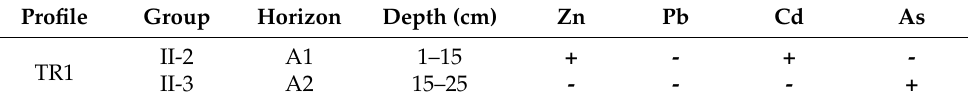
Table 7. Exceeded content of trace elements in soils (group II) according to the Polish regulation